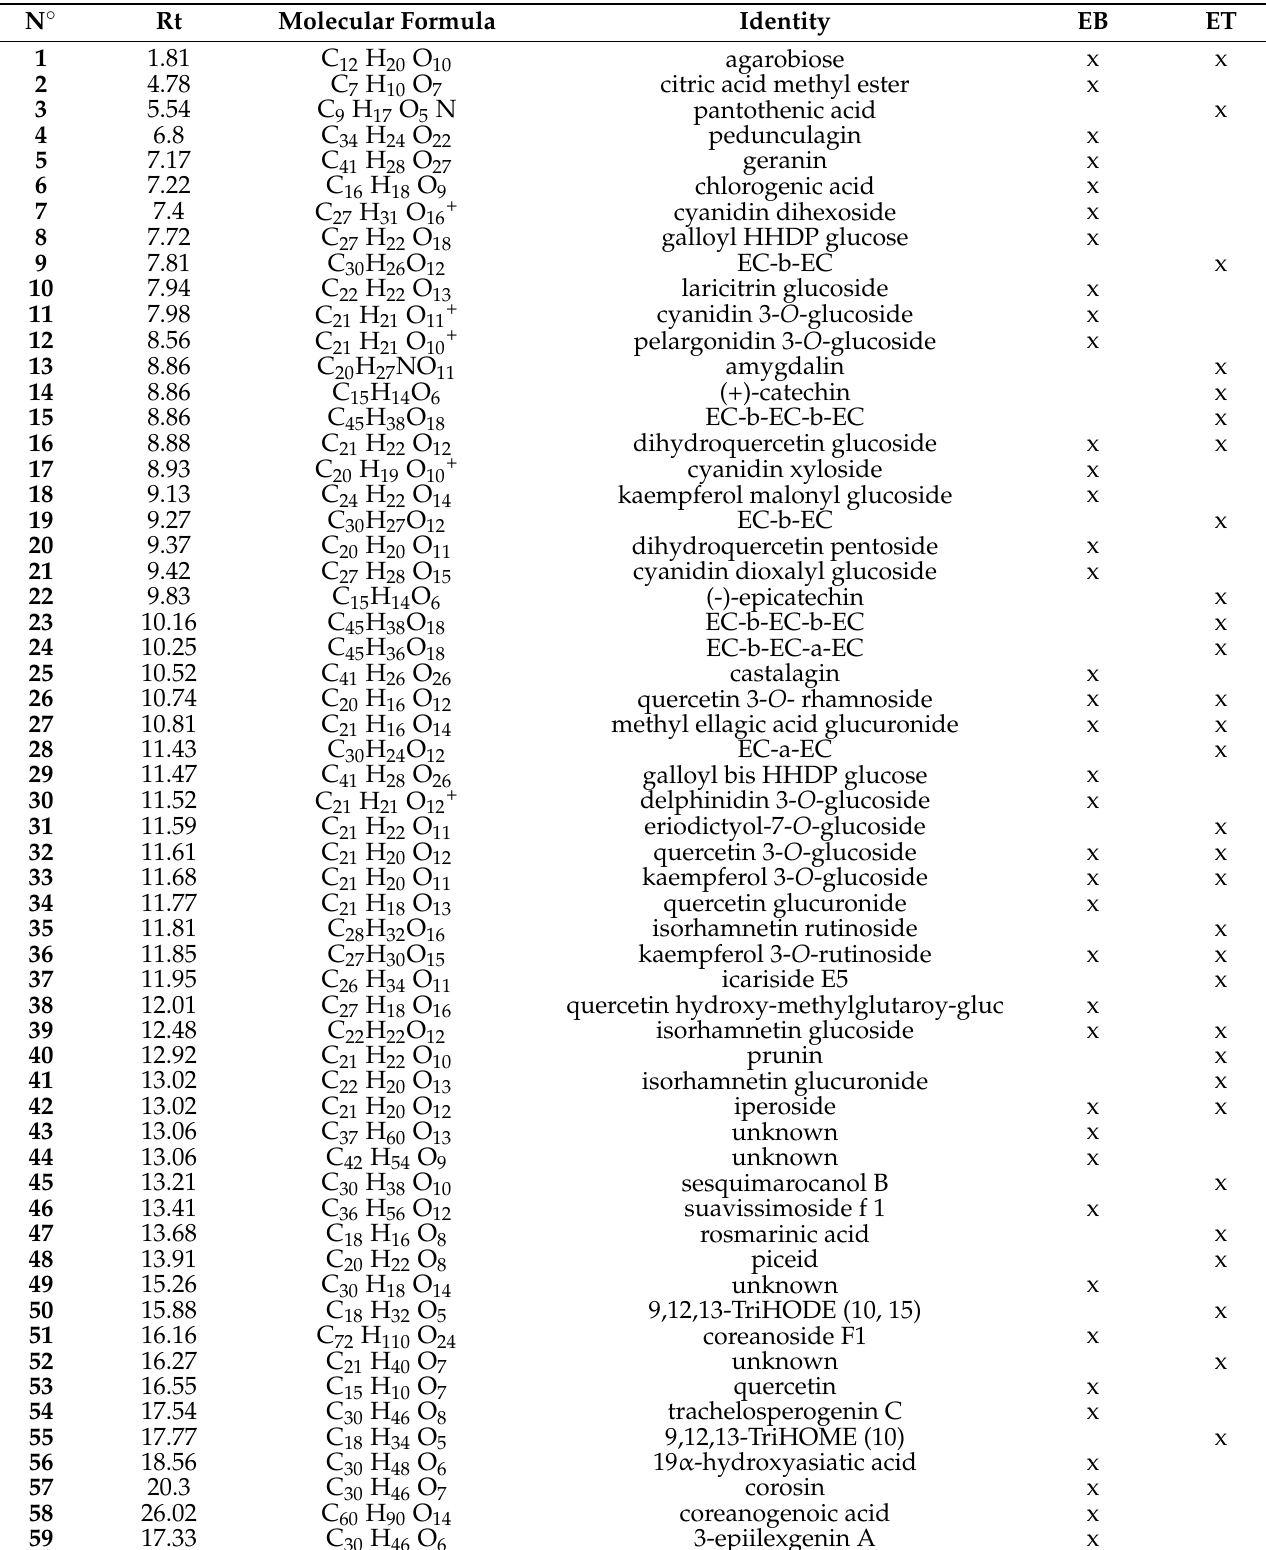
Table 2. Secondary metabolites identified in ethanol extract of blackberry fruits (EB) and in ethanol extract of almond skin (ET) by LC-ESI/LTQOrbitrap/MS/MSn